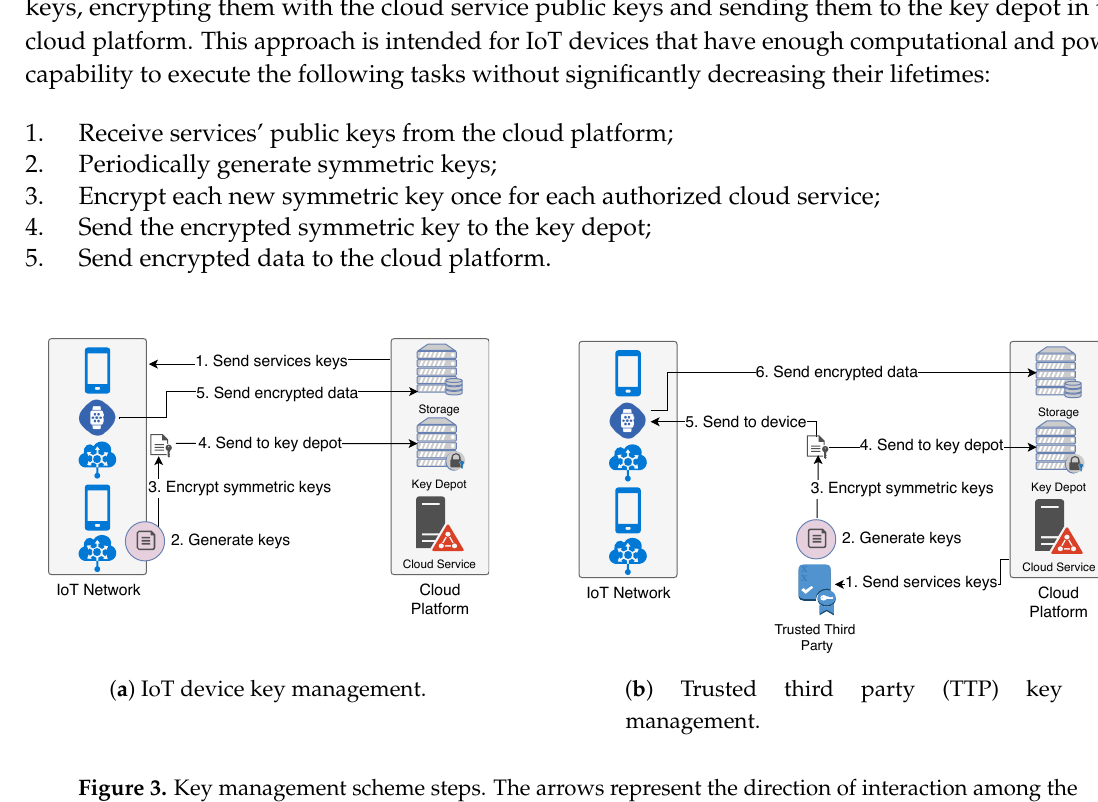
Figure 3. Key management scheme steps. The arrows represent the direction of interaction among the entities. The numbers represent the order and the corresponding